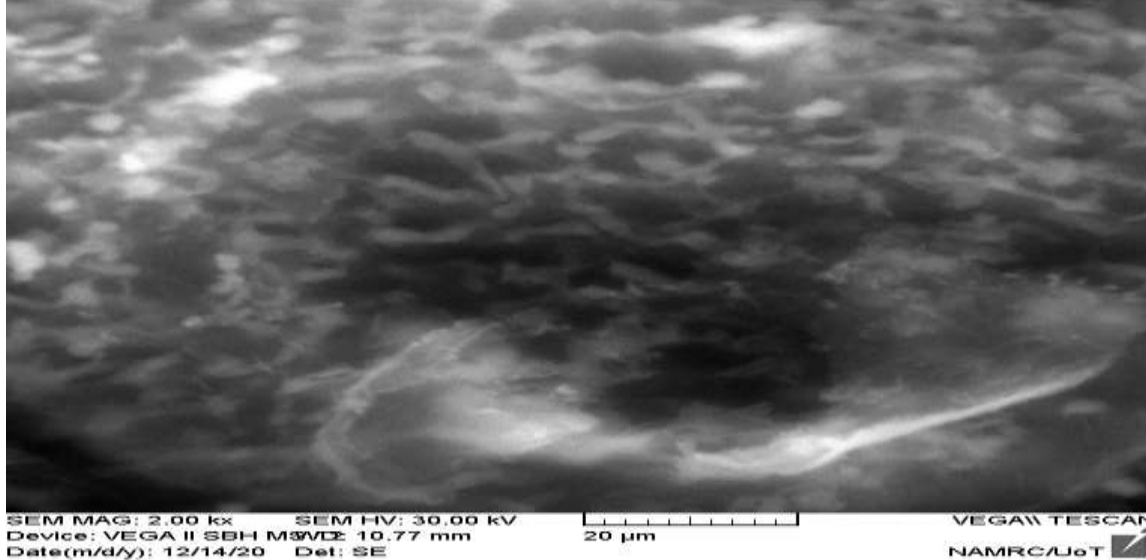
Figure 13. SEM of risperidone pure